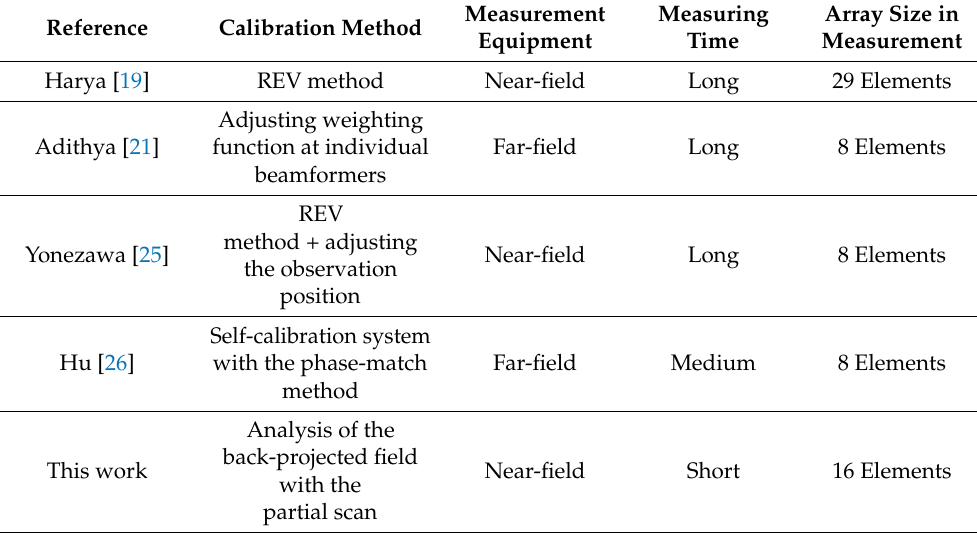
Table 1. Comparisons of calibration methods.